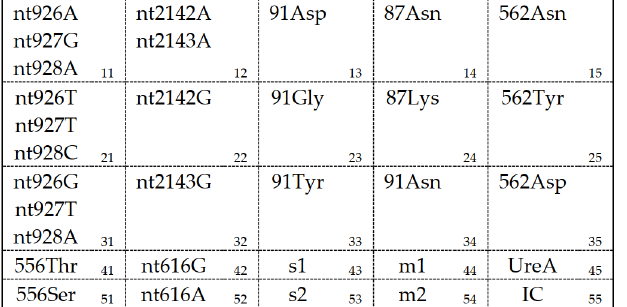
Figure 1. The distribution of H. pylori -associated gene probes on membrane strips. 11 – 15, 41 – 42 represent H. pylori wild – type sequences; 21 – 25, 31 – 35, 51 – 52 represent H. pylori mutant sequences; 43 – 44, 53 – 54 represent H. pylori virulence genotyping.